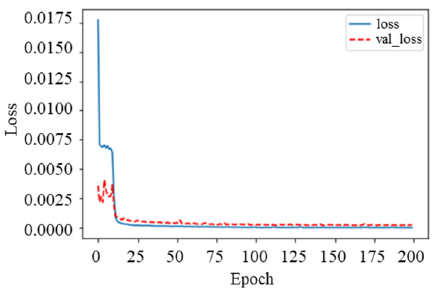
Figure 8. Loss for training data and validation data in Case 2.